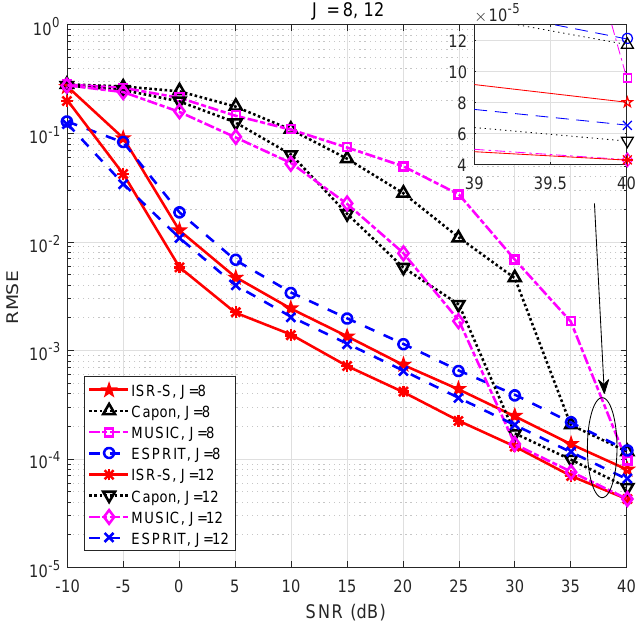
Figure 4. Comparison with existing MIMO radar target localization methods for different antenna numbers J , L = 48.